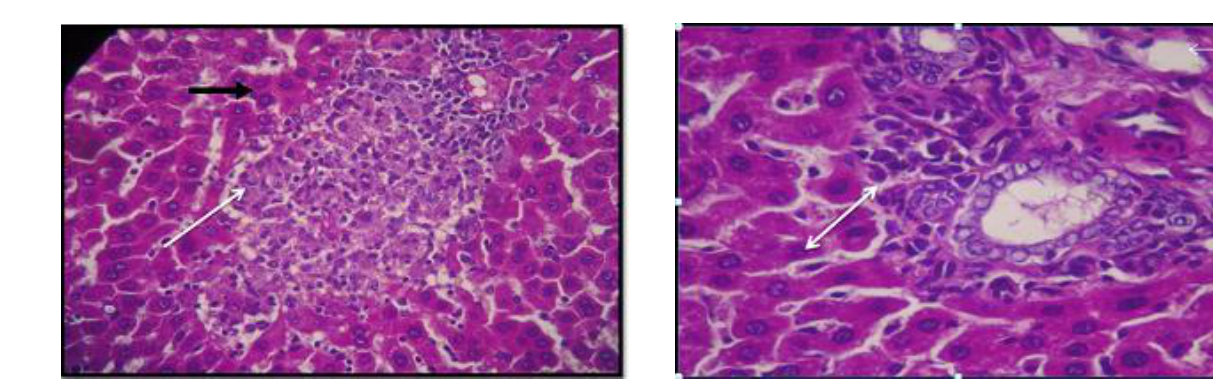
Figure,6: Photomicrographs showing histology of liver tissue from control rat. Note normal characteristics feature of the liver (H -E X 40).